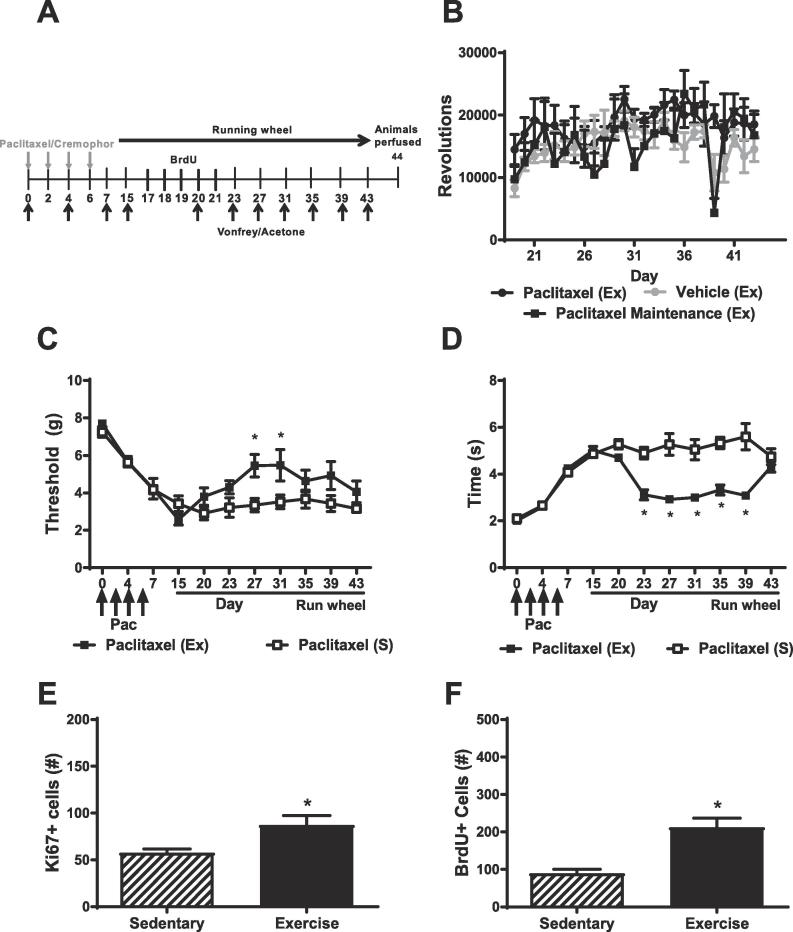
Voluntary running partially alleviates the maintenance of already established paclitaxel-induced allodynia. (A) Schematic shows timing of experimental procedures in Study 3. Voluntary running was initiated 15 days after paclitaxel (4 mg/kg i.p. on day 0, 2, 4 and 6) or vehicle injections. Mechanical and cold responsiveness was assessed prior to the start and throughout the duration of running wheel access. BrdU (100 mg/kg i.p.) was administered once daily across 5 consecutive days during the maintenance phase of paclitaxel-induced neuropathy approximately 2 days following introduction of running wheels or no wheels. Animals were perfused 44 days post paclitaxel injection. (B) Running rates did not differ in mice exposed to running wheels during the maintenance of paclitaxel-induced allodynia (paclitaxel maintenance) from those exposed concurrently with vehicle or paclitaxel treatment (paclitaxel development). Voluntary running partially attenuated paclitaxel-induced (C) mechanical and (D) cold hypersensitivities. This effect appeared to be limited to different time windows, depending on the stimulus modality assessed. Voluntary running during the maintenance phase of CIPN increased the number of Ki67 (E) and BrdU (F) expressing cells compared to paclitaxel-treated sedentary mice. Mice were exposed to running wheels for a period of 28 days or lacked access to running wheels throughout the study.*p < 0.05 vs. Paclitaxel S, two-way ANOVA followed by Bonferroni post-hoc test. Exercise, Ex, indicates subjects exposed to running wheels. Sedentary, S, indicates subjects housed without running wheels. Arrows denoting injections (inj) denote timing of paclitaxel or vehicle injection. Horizontal arrow denotes timing of voluntary running.